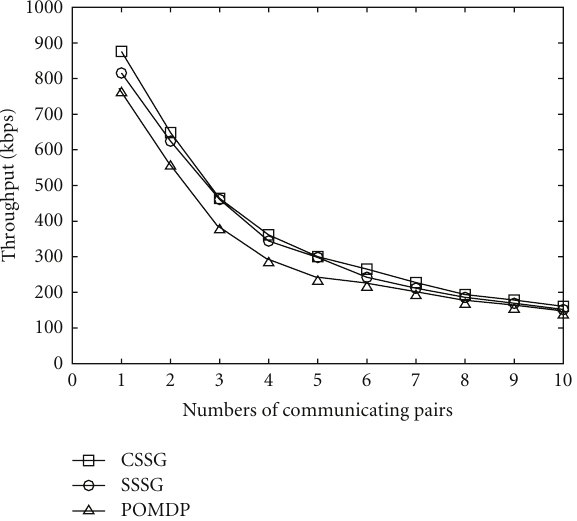
Figure 12: Aggregate throughput of CSSG with 1 channel having PU’s interference.